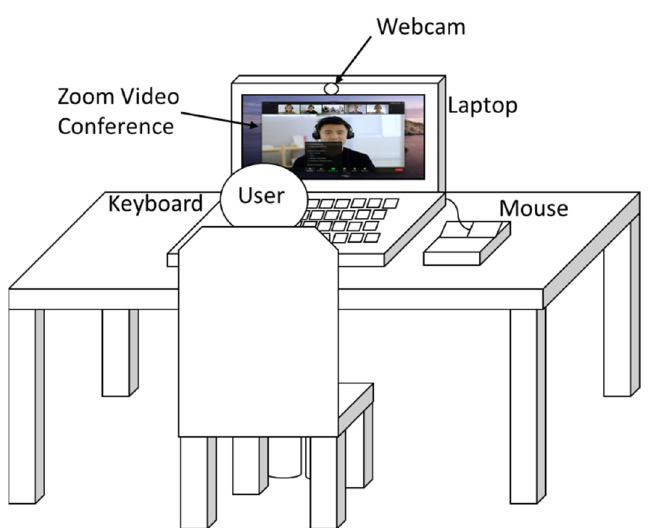
Figure 2. Experimental set up and layout of equipment.